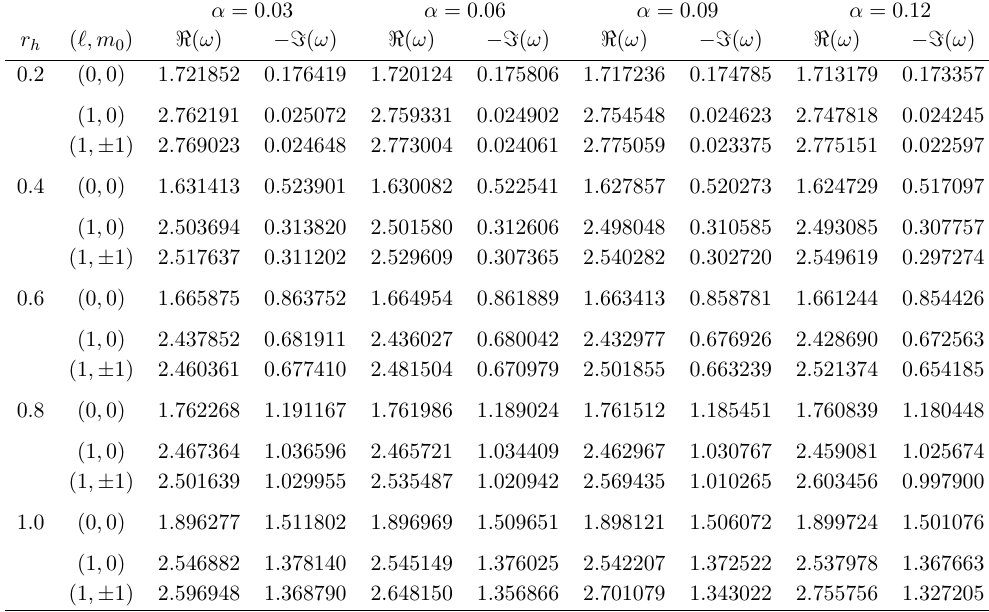
Table 2 . Quasinormal modes of accelerating Schwarzschild AdS black holes with Λ = − 3